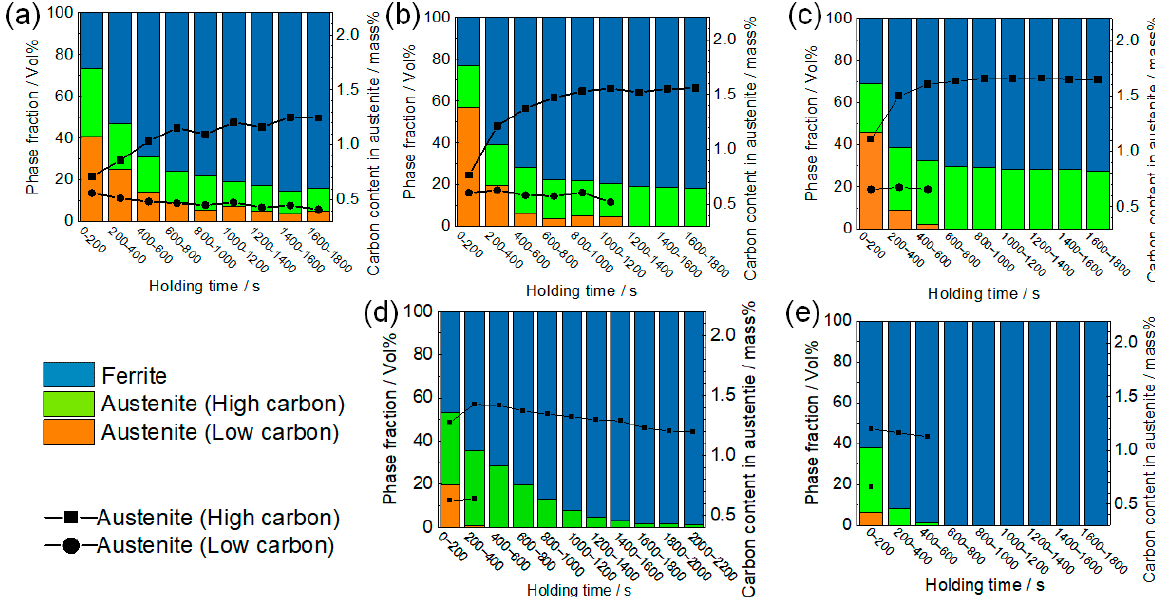
Figure 5. The phase fractions and carbon concentrations in high and low carbon austenite during austempering at various temperatures: ( a ) 573 K, ( b ) 623 K, ( c ) 673 K, ( d ) 723 K, and ( e ) 773 K. Among the temperatures, it is found that the low carbon austenite has a carbon con ‐ centration close to 0.6 mass%, which is the bulk composition. This means that the expelled carbon from bainite did not spread rapidly but formed the high concentration regions.